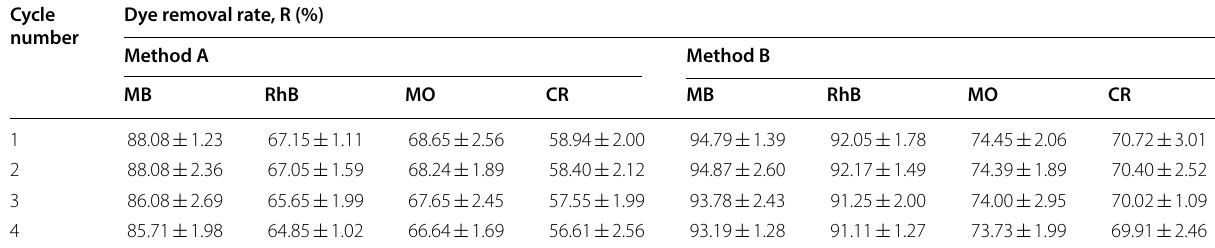
Table 1 The dye removal rate obtained for the GC_15 composite hydrogel column during the reuse process Cycle Dye removal rate, R (%) number Method